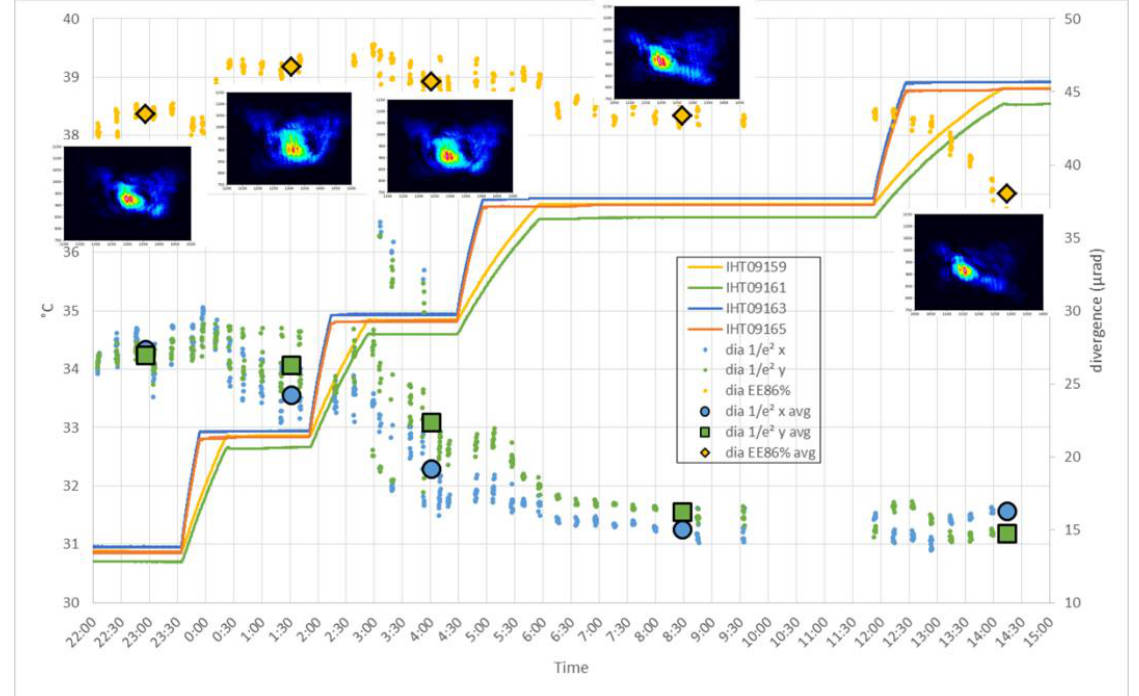
Figure 9. Far field measurement results during EDC; the variation of beam divergence ( right scale ) is measured and averaged for various EBEX temperatures (thermistor readings on the ( left scale )). The yellow diamonds indicate averaged divergence measurements at 86% encircled energy, with associated camera acquired far field pattern images overlaid. The blue circles and green squares indicate averaged measurement, in x and y, of angular width at 1/e 2 of maximum. The solid lines indicate thermistor acquired temperature